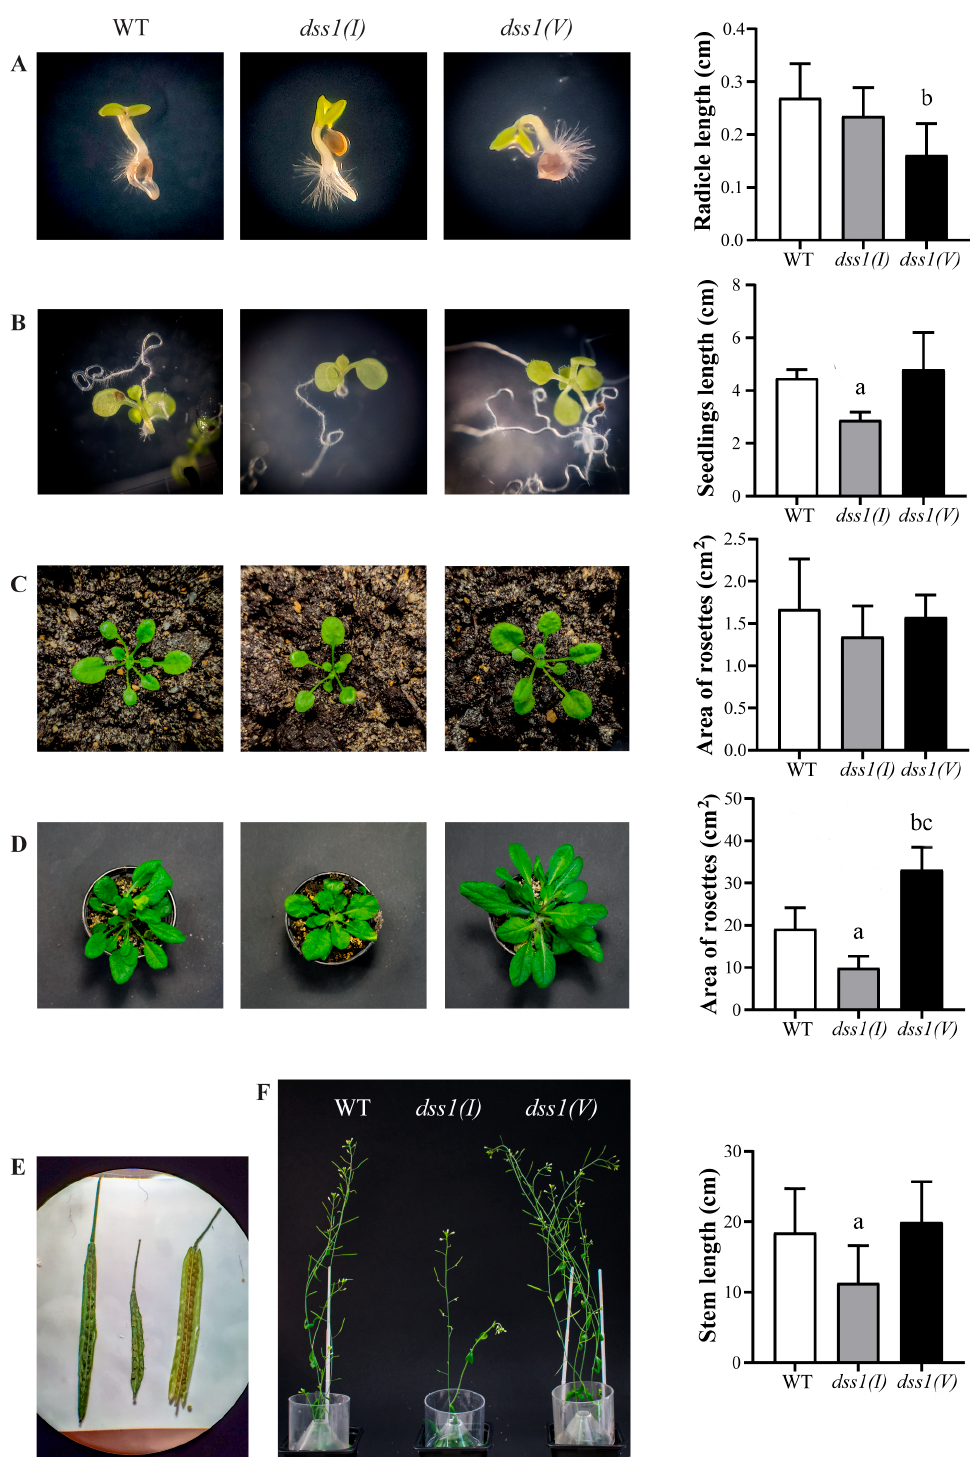
Figure 5. Phenotypic differences between Arabidopsis WT, dss1(I) and dss1(V) mutant lines during development. Seeds were cultured on the Murashige and Skoog (MS) solid medium under long-day conditions. After 2 weeks of growth in MS, all plants were transplanted into soil. ( A ) Images of 2-day-old WT, dss1(I) , and dss1(V) mutant plants grown on MS and histogram of radicle length in cm. ( B ) Images of 12-day-old plants grown in MS and histogram of seedling length in cm. ( C ) Images of 25-day-old plants grown in soil and histogram of rosette area in cm 2 . ( D ) Images of 7-week-old plants in soil and histogram of the rosette area in cm 2 . ( E ) Representative image of WT (left), dss1(I)